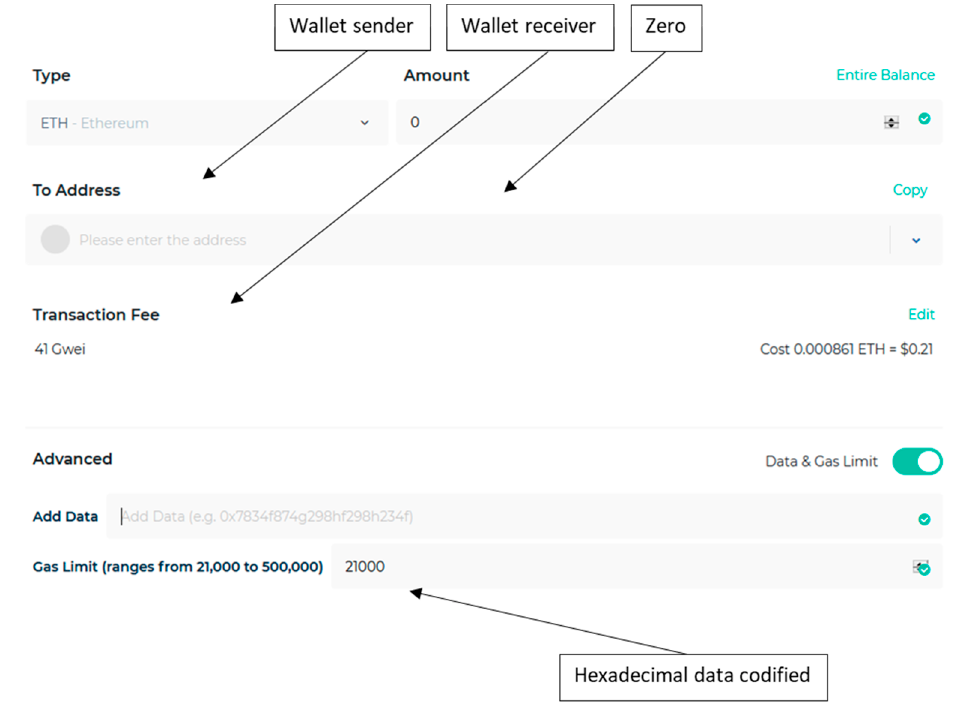
Figure 1. Ethereum blockchain transaction.